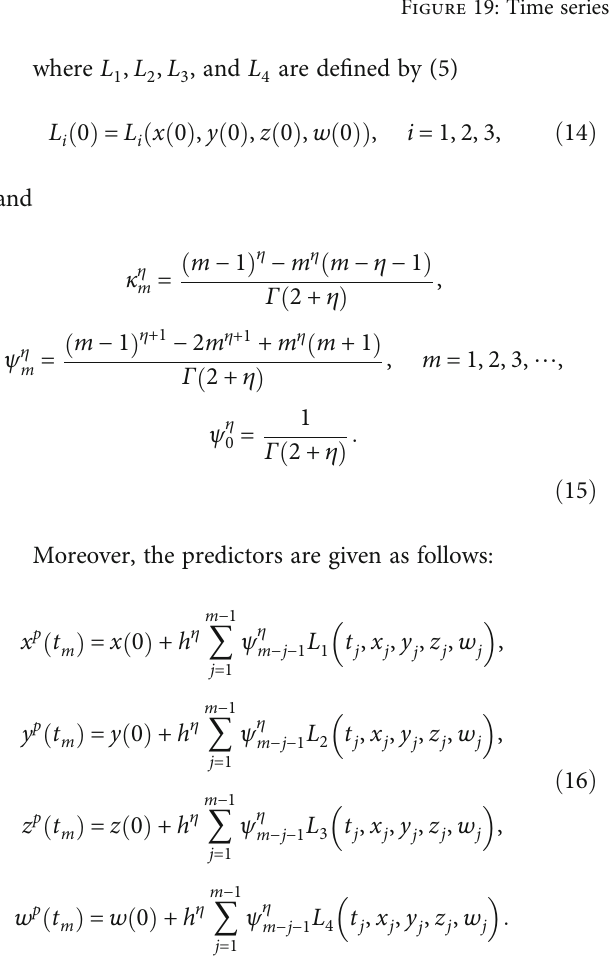
Figure 19: Time series orbits of w ð t Þ and w